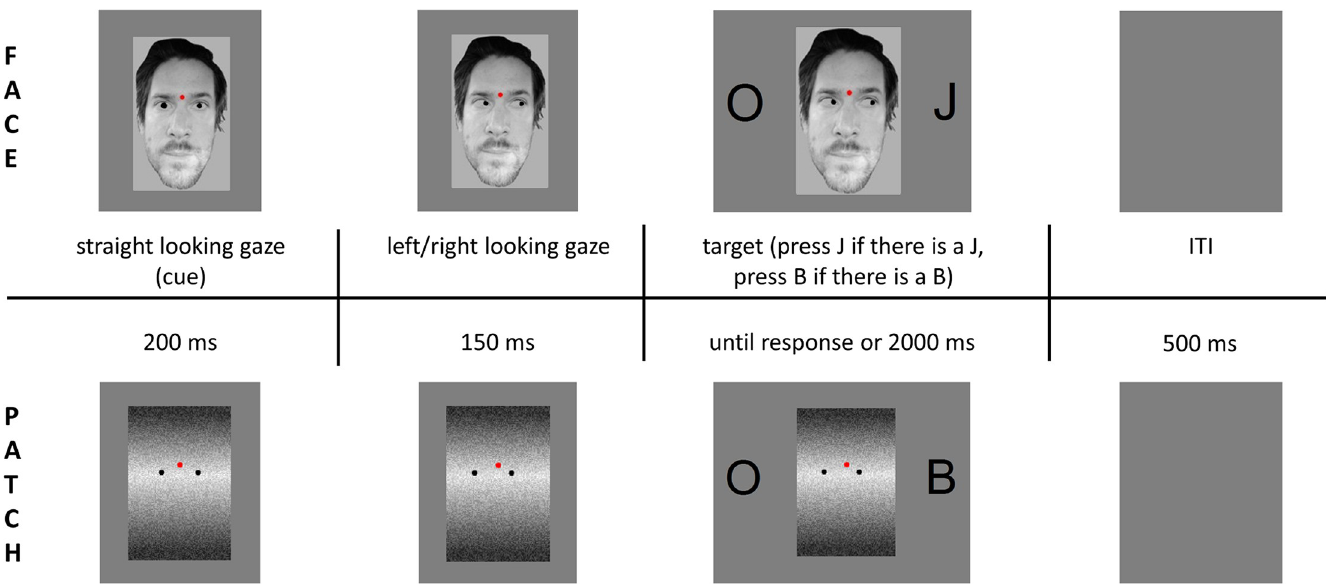
Fig 2. Illustration of the sequence and timing of stimuli in the face cued trials (top row) and the patch cued trials (bottom row). ITI is for intertrial interval.